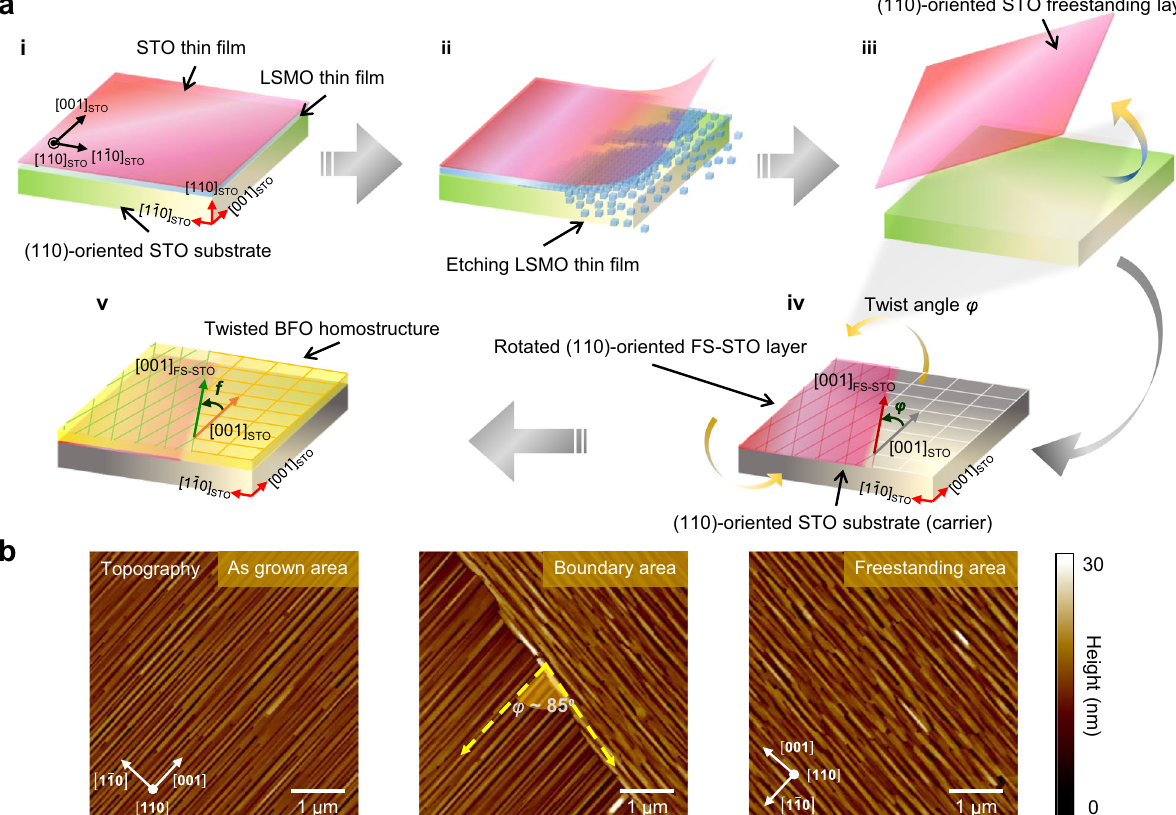
Fig. 1 Synthesis of the lateral oxide homostructures. a Process fl ow for fabricating twisted lateral oxide homostructures. (i) Growth of STO with a LSMO sacri fi cial layer on (110)-oriented STO single crystal substrate. (ii) Etching of the LSMO sacri fi cial layer. (iii) Releasing and (iv) transferring the freestanding STO layer with designated twist angle with respect to the selected single-crystal carrier substrates. (v) Deposition of BFO thin fi lm on the twisted template. b Topography images of (110)-oriented BFO grown on pristine STO, boundary, and FS-STO region, respectively. The [001] pc -oriented stripes serve as the direction reference of epitaxial BFO, identifying the in-plane directions of (110)-oriented BFO and the twist angle (denoted as angle φ ) at the boundary of pristine STO and FS-STO